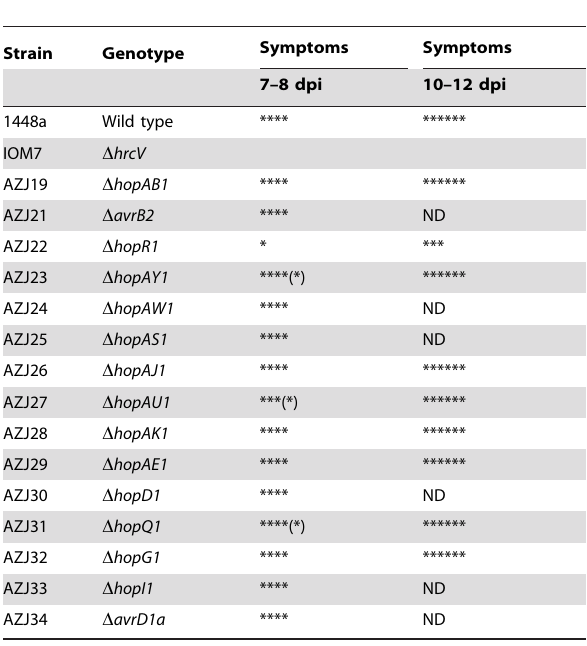
Table 2. Analysis of symptom development after inoculation with different